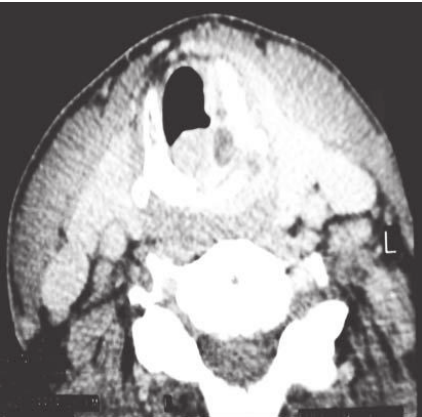
Figure 1: CT of neck. Invading mass of the larynx with subglottic and intralaryngeal extension.